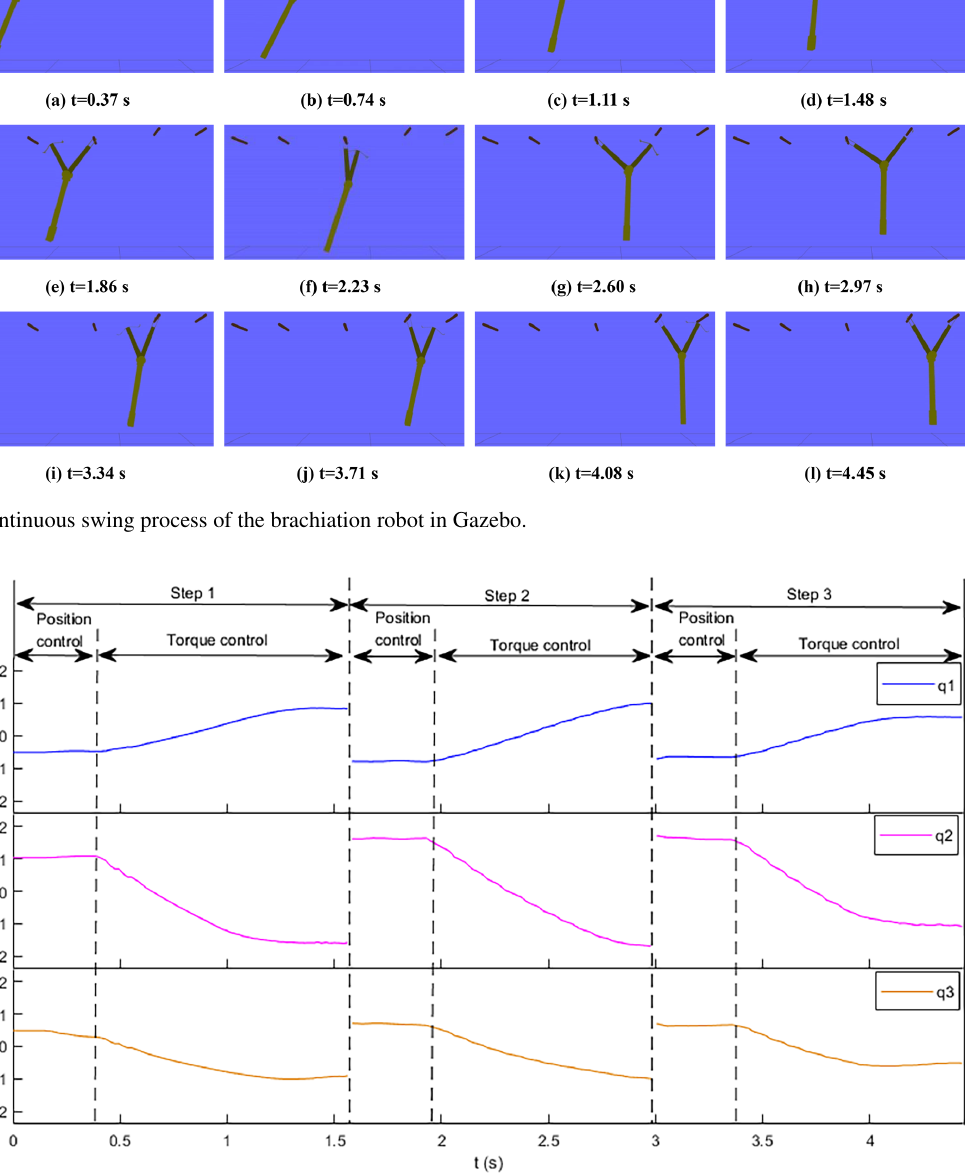
Figure 10. The angles of the brachiation